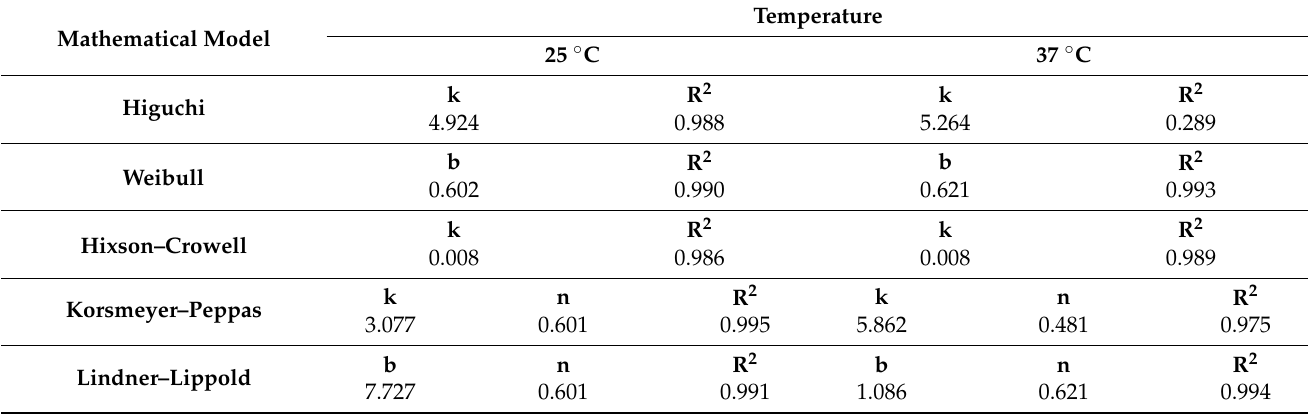
Table 5. Mathematical models used for the prediction of kinetic release in the first 3